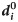
Residue-specific potential energies for Im9 H1→H2 at di0 = 1.10 nm.(A) Lennard-Jones (filled) and electrostatic (hashed) potential energies for direct interaction of selected interfacial residue pairs from the native configuration (red) and a nonnative (blue) configuration with H1 rotated by +30°. Pairs with |ΔE| > 1 kJ/mol are circled (S1 Text). (B) Snapshot of H1 (orange) packed against H2 (blue) in the native orientation, superposed with the configuration with a nonnative +30° rotation of H1 (both helices in grey). Sidechains involved in residue pairs with |ΔE| > 1 kJ/mol, identified in (A), are shown as sticks. (C, D) Helical wheels show (C) native and (D) nonnative interactions between residues that contribute to the more favorable (red dashed lines) and more unfavorable (green dashed lines) component binding energies for nonnative than for native packing (see part A). As in Fig 1, amino acid residues on the helical wheels are color coded: grey for charged, yellow for nonpolar, and white for polar residues.